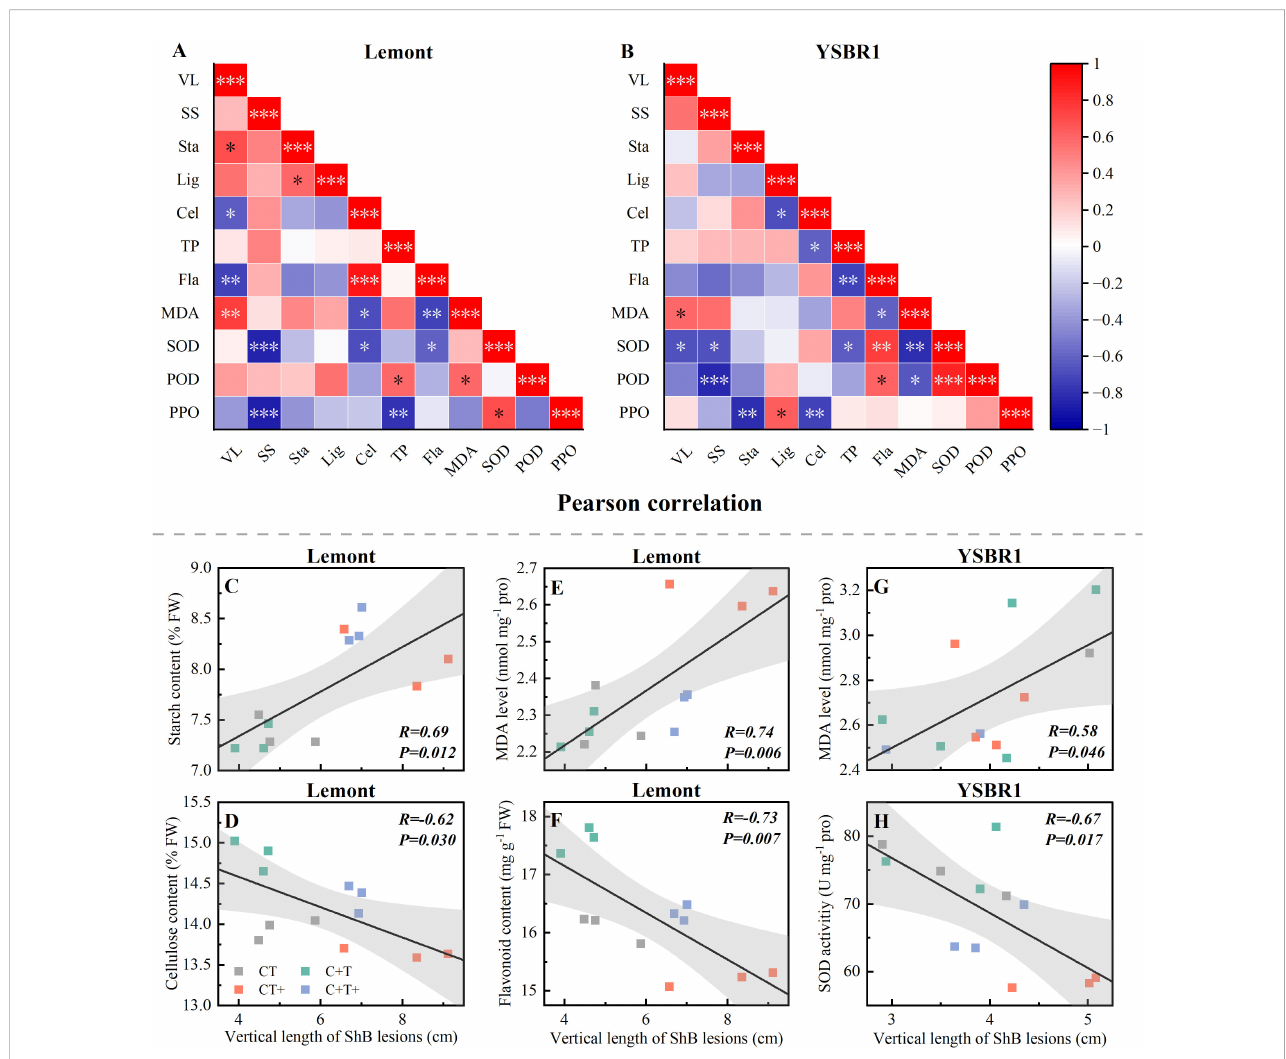
FIGURE 3 (A, B) Pearson correlation R 2 of vertical length of ShB lesions and physiological parameters in inoculated stems of cvs Lemont (A) and YSBR1 (B) under ambient condition (CT), elevated CO 2 (C+T), elevated temperature (CT+), and the combination of elevated CO 2 and elevated temperature (C+T+) in T- FACE experiments of 2021. VL, vertical length of ShB lesions; SS, soluble sugar; Sta, starch; Lig, lignin; Cel, cellulose; TP, total phenol; Fla, fl avonoid; MDA, malondialdehyde; SOD, superoxide dismutase; POD, peroxidase; PPO, polyphenol oxidase. * p < = 0.05, ** p < = 0.01, *** p < = 0.001. (C-H) Individual measures, regression line, correlation coef fi cient R 2 , con fi dence interval (95%), and P -value for cv. Lemont (C) Sta vs VL, (D) Cel vs VL, (E) MDA vs VL, (F) Fla vs VL, and cv. YSBR1 (G) MDA vs VL, (H) SOD vs VL.